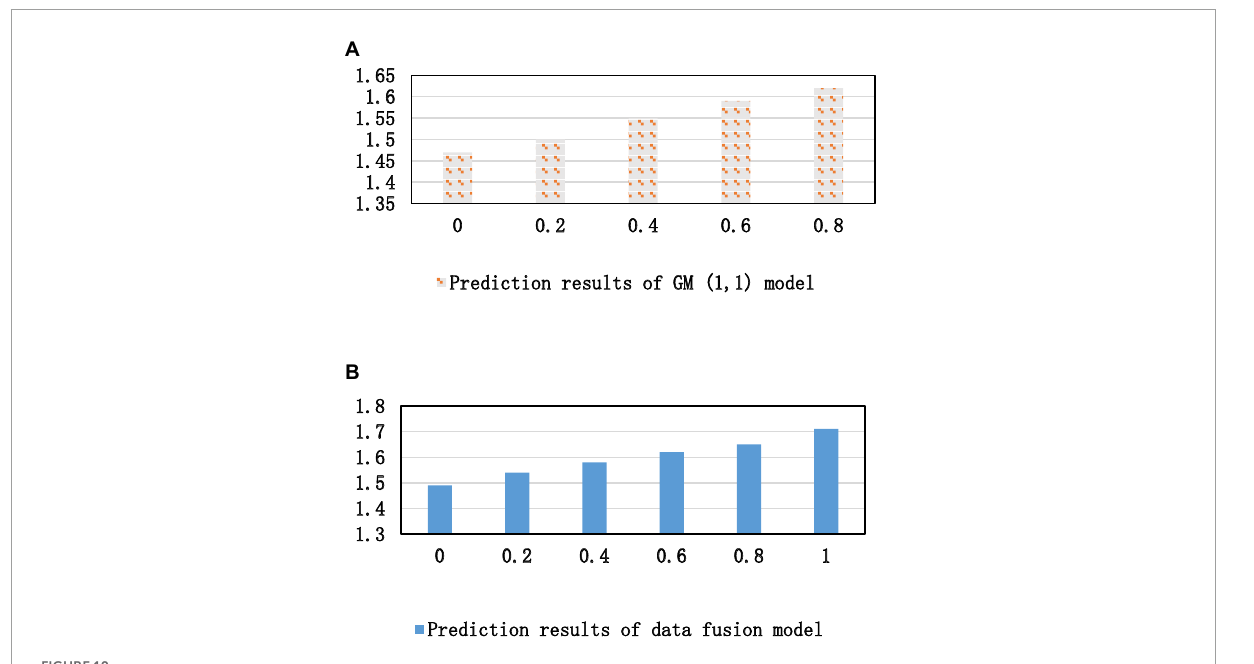
FIGURE10 Prediction results of two models. (A) Prediction results of the GM model. (B) Prediction results of the data fusion model.